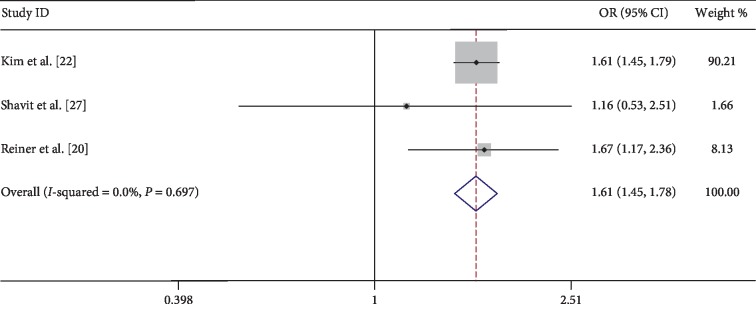
Forest of comparison: urolithiasis versus without urolithiasis and event: arteriosclerosis in people with normal uric acid. OR: odds ratio; CI: confidence interval.